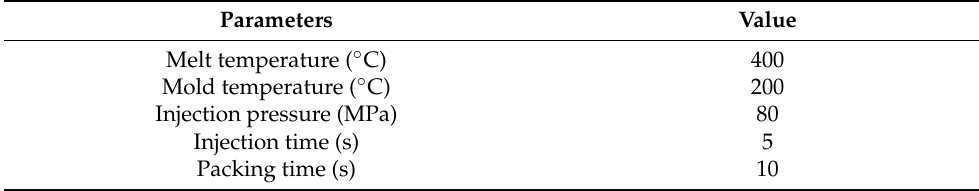
Figure 1. ( a ) Fabrication process for the PEEK/CNTs composites with a twin-screw extruder; ( b ) tensile specimen schematic; ( c ) conductive specimen schematic. Table 1. Parameters for injection ‐ molding.